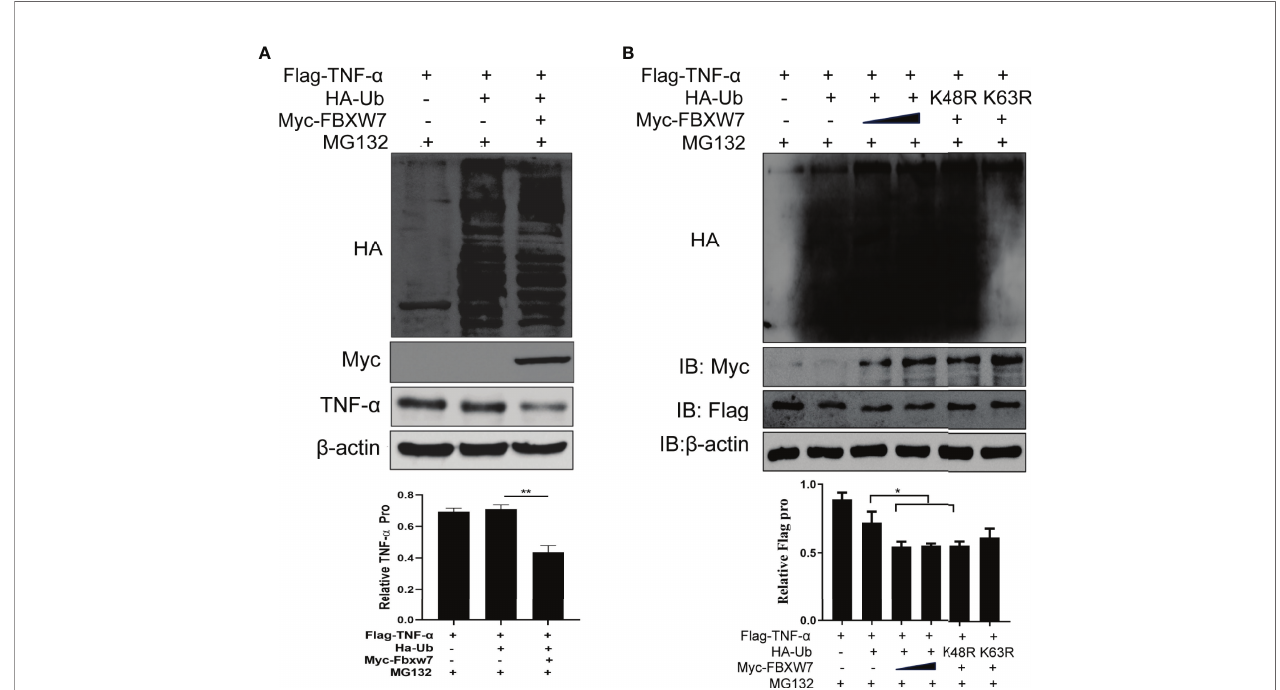
FIGURE 6 | FBXW7 facilitates the degradation of TNF- a by K63-linked ubiquitylation. (A) Immunoblot of Raw264.7 cells co-transfected for 48 h with Myc-FBXW7, plus Flag-TNF- a , HA-ub and treated with MG132 before cell harvest; adding FBXW7 to the system signi fi cantly decreases TNF- a ( P = 0.01) (B) Immunoblot of Raw264.7 cells co-transfected with Flag-TNF- a , Myc-FBXW7 along with Ha-Ub, the mutant ubiquitin Ha-K48R Ub or Ha-K63R Ub and treated with MG132 before cell harvest. Similarly, the addition of myc-FBXW7 and K48R mutant Ha-Ub reduced the expression of Flag-TNF- a signi fi cantly ( P = 0.05). The experiments were performed three times with similar results. * P < 0.05 and ** P <